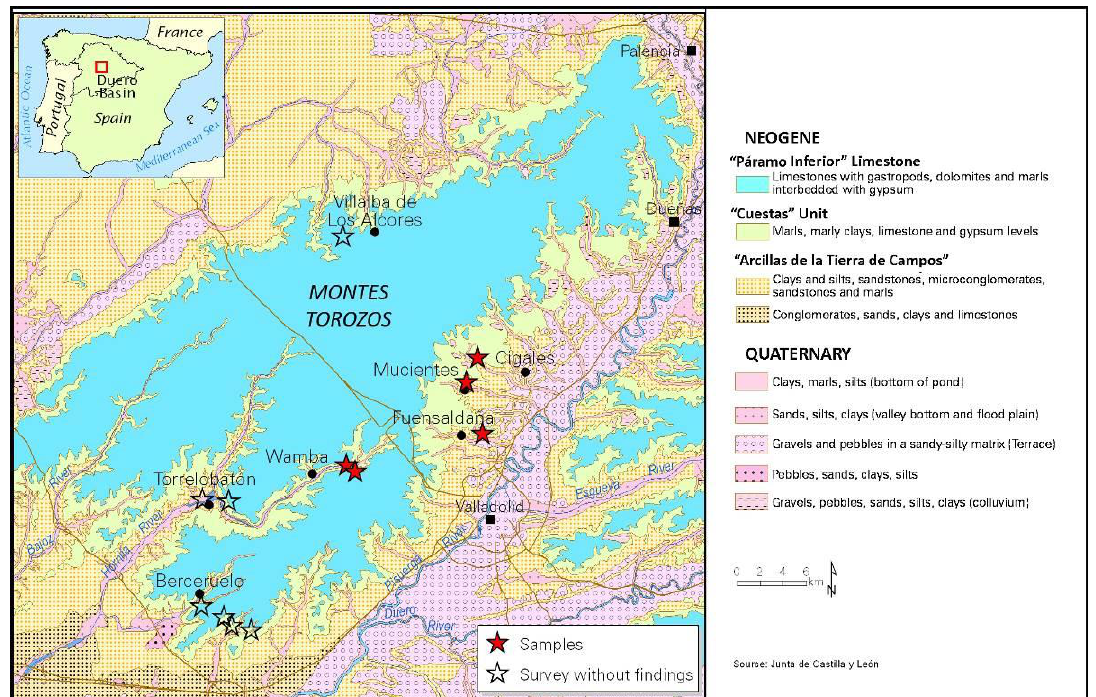
Figure 2. Geological map of the region (Source: Cartographic database of Junta de Castilla y León, Geology: synthesis from Portal de Datos Abiertos of Junta de Castilla y León). Black dots: localities where chert has been cited in geological literature. Empty stars: areas prospected without finds. Full stars: locations of the chert samples that have been